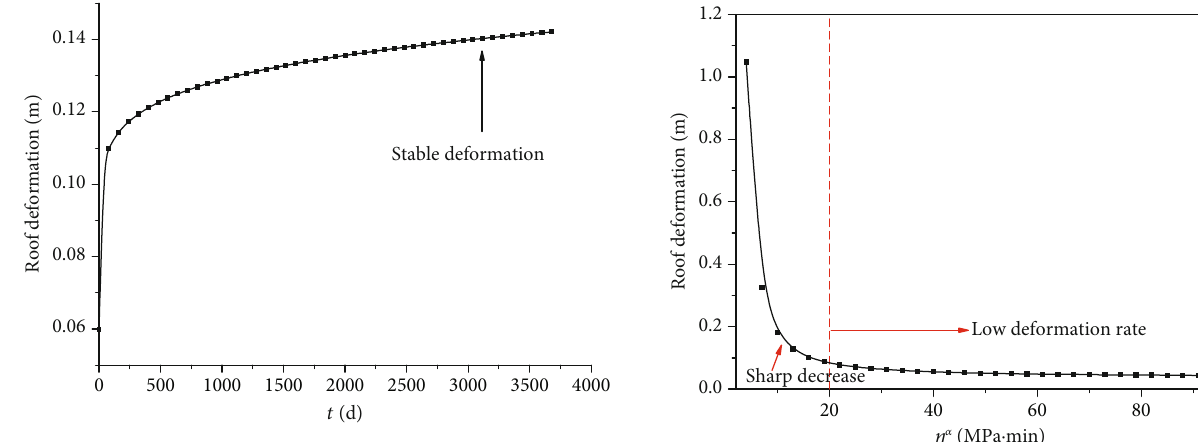
Figure 9: Relationship of maximum roof subsidence and time.